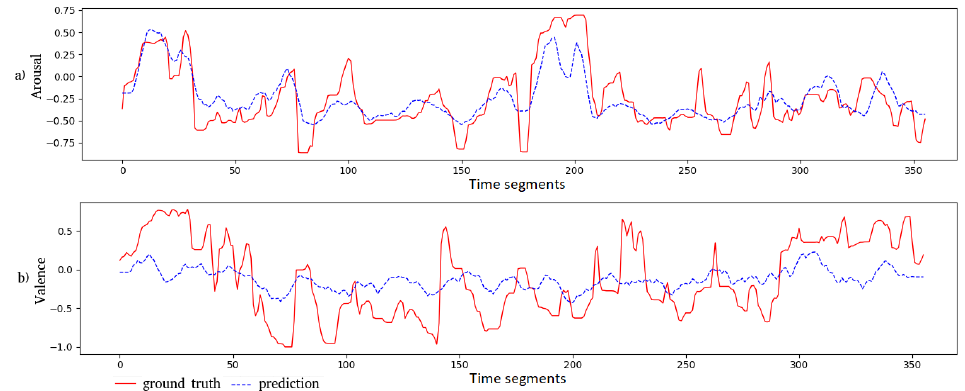
Figure 5. Both the ground truth and the predicted outputs of the Feature AAN model for the “Shakespeare in Love” movie clip are visualized: ( a ) for arousal and ( b ) for valence. Each time segment in the graphs corresponds to 5 s, which is also the length of each movie part.